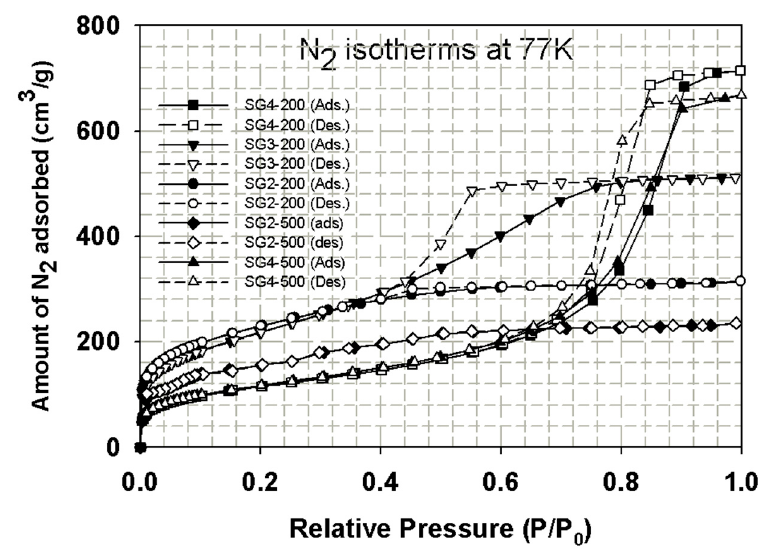
Figure 5. Isotherms of nitrogen adsorption at 77 K on the porous silica glass samples prepared with different pH values.